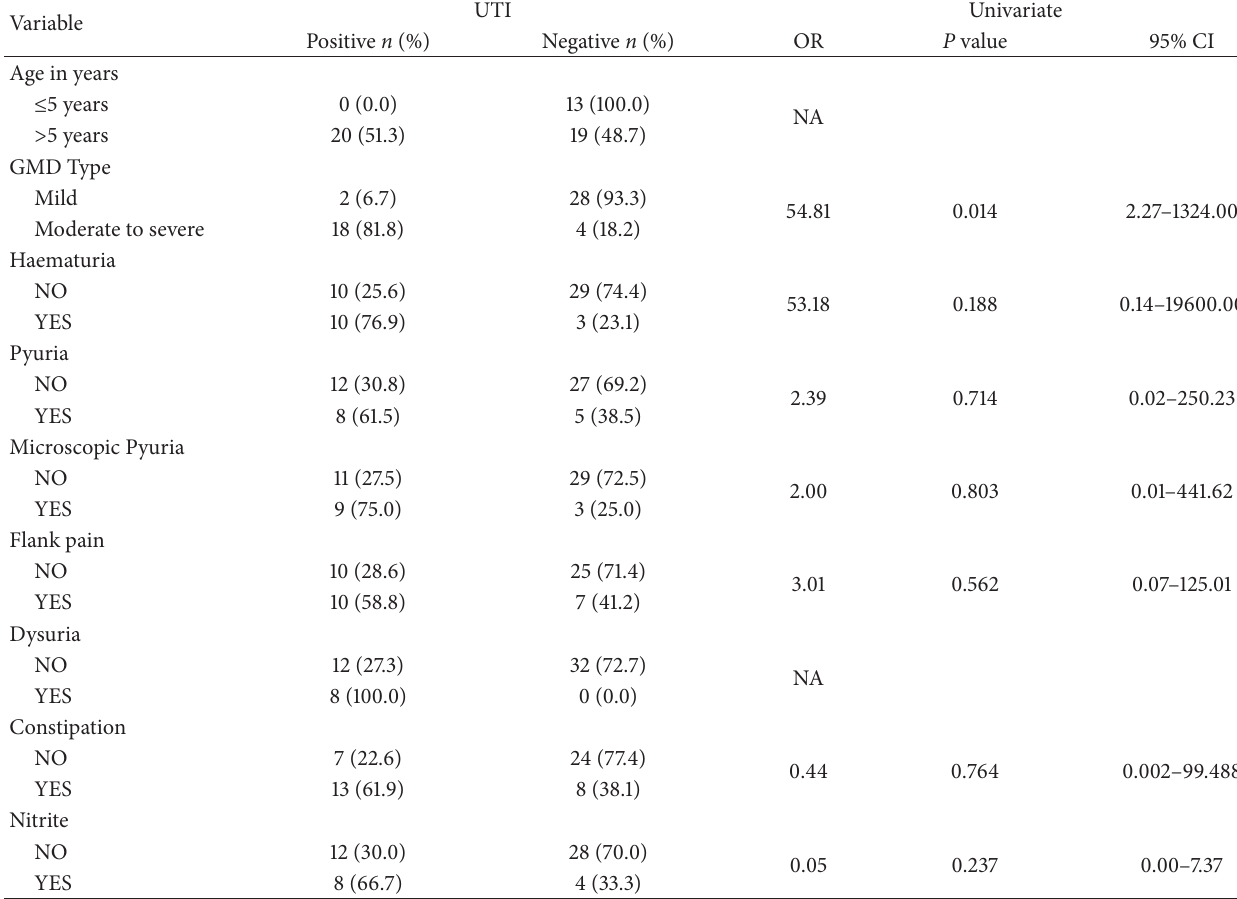
Table 6: Predictors of UTI among the children with cerebral